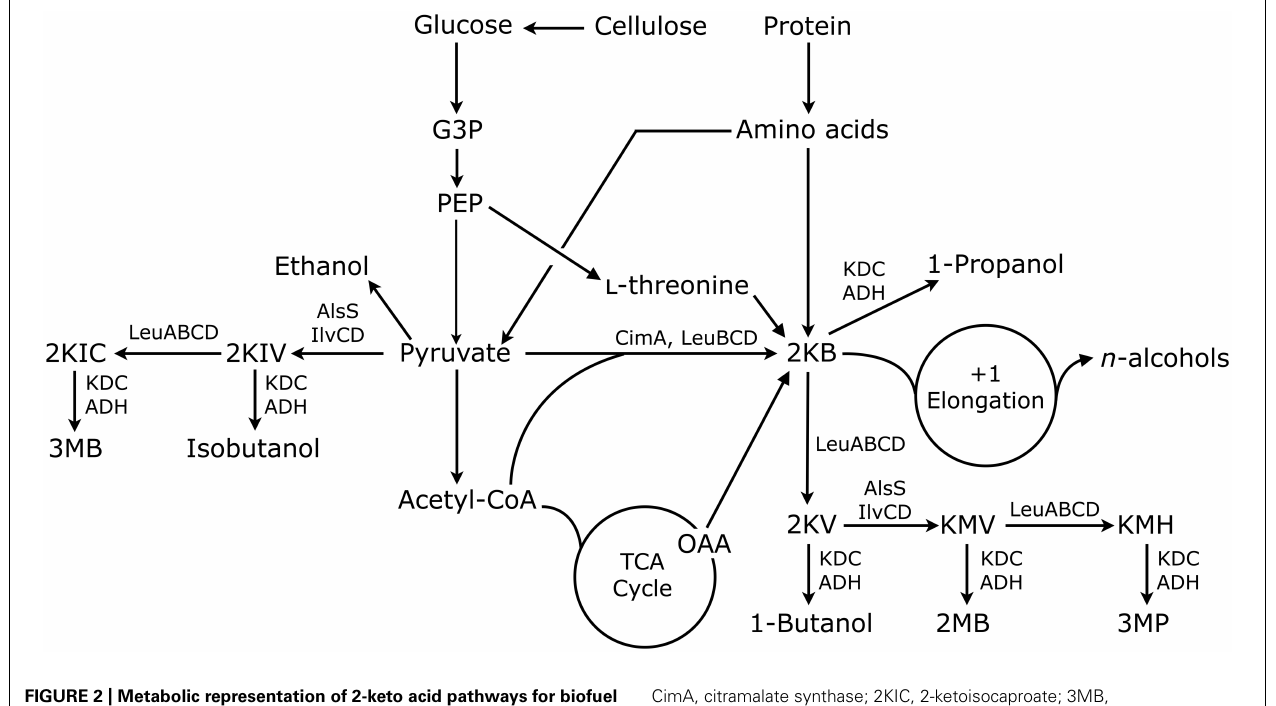
FIGURE 2 | Metabolic representation of 2-keto acid pathways for biofuel production. G3P, glyceraldehyde-3-phosphate; PEP, phosphoenolpyruvate; AlsS, acetolactate synthase; IlvC, acetohydroxy acid isomeroreductase; IlvD, dihydroxy-acid dehydratase; LeuA, isopropylmalate synthase; LeuB, isopropylmalate dehydrogenase; LeuCD, isopropylmalate dehydratase;